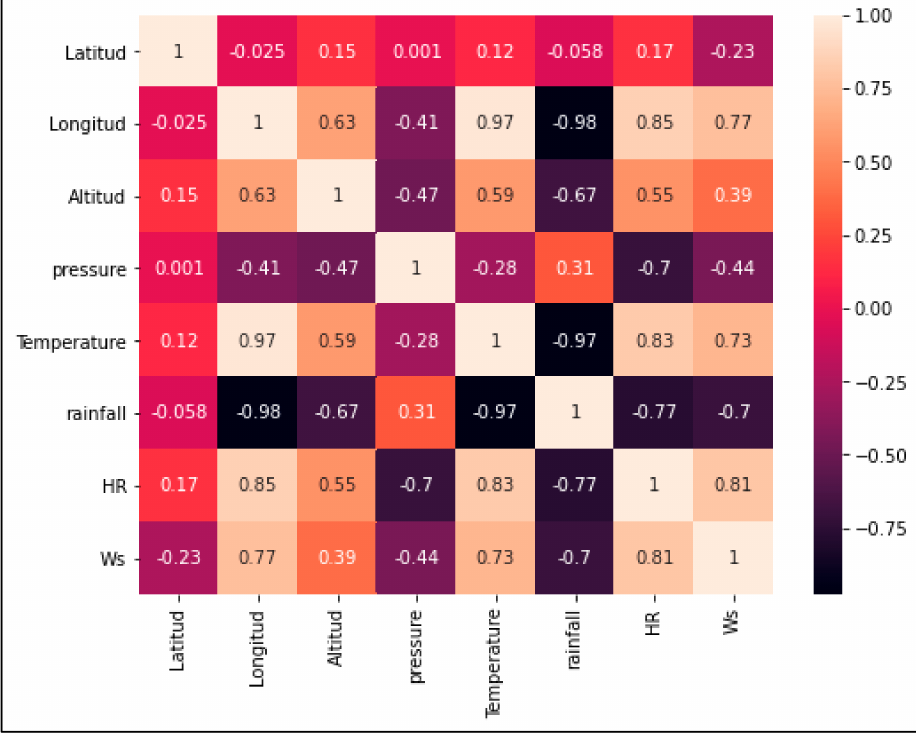
Figure 6. Correlation matrix of Hurst exponents for the time series made up of days without Santa Ana